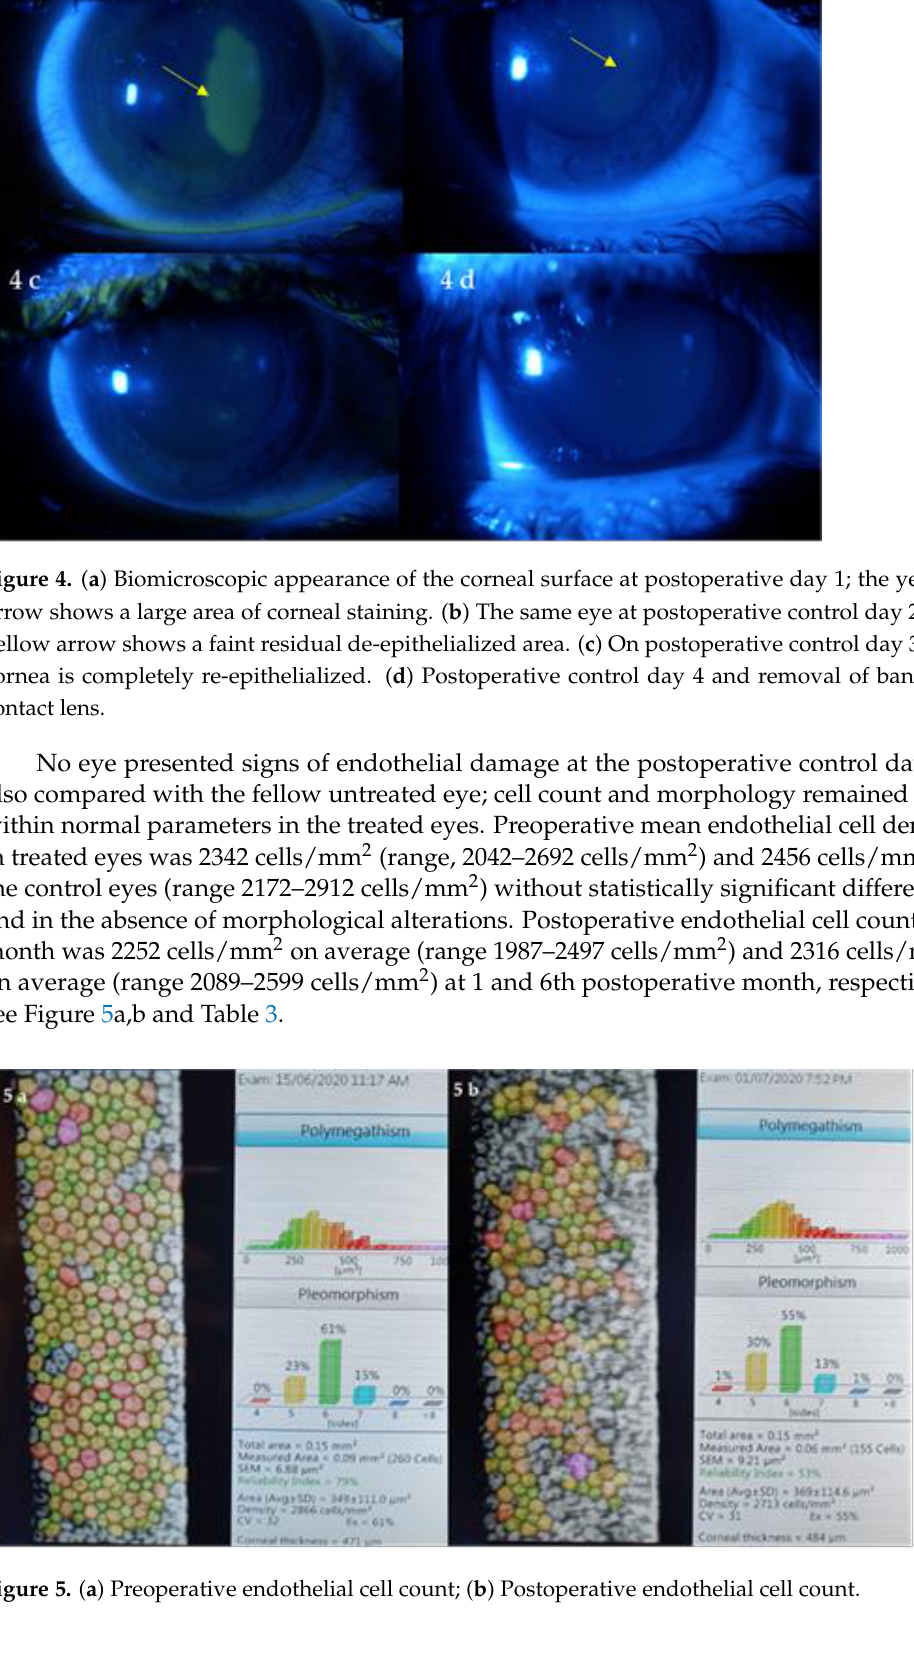
Figure 5. ( a ) Preoperative endothelial cell count; ( b ) Postoperative endothelial cell count. Morphologically, the chemically-boosted CXL, provided by this novel medical de- vice, resulted in an increased depth of cross-linking demarcation line compared to stand- ard riboflavin solutions up to 20%, thus enhancing the volume of the treatment and rea- sonably its efficiency through the higher release of superoxide anion granted from its chemical formula, boosting up the effect of CXL penetration. Indeed, the demarcation line depth (DLD), measured by spectral domain anterior-segment (AS) corneal OCT in the first postoperative month, was found at a mean depth of 355.8 with a range of 329 µm – 380 µm (20% over a 0.1% riboflavin solution with 1% HPMC vehicle and with same irradiation parameters), see Figure 6 and Table 3. Figure 6. First postoperative month control shows the demarcation line depth (DLD, white ar- rows) as measured by spectral domain anterior-segment (AS) corneal OCT (optical coherence to- mography). Anterior segment optical coherence tomography at first postoperative month, show- ing the depth of the demarcation lines between a 0.1% riboflavin solution with 1% HPMC vehicle and after 9 mW/5.4 J/cm 2 ACXL, Figure 7a, and 0.25% riboflavin plus 1% HPMC SafeCross solution, Figure 7b after the same ACXL protocol, shows a 20% of higher pene- tration in the SafeCross ® treatment, reasonably due to the higher riboflavin concentration, optimized osmolarity, and reduced salt concentration, releasing a higher amount of su- peroxide anion in the corneal stroma.